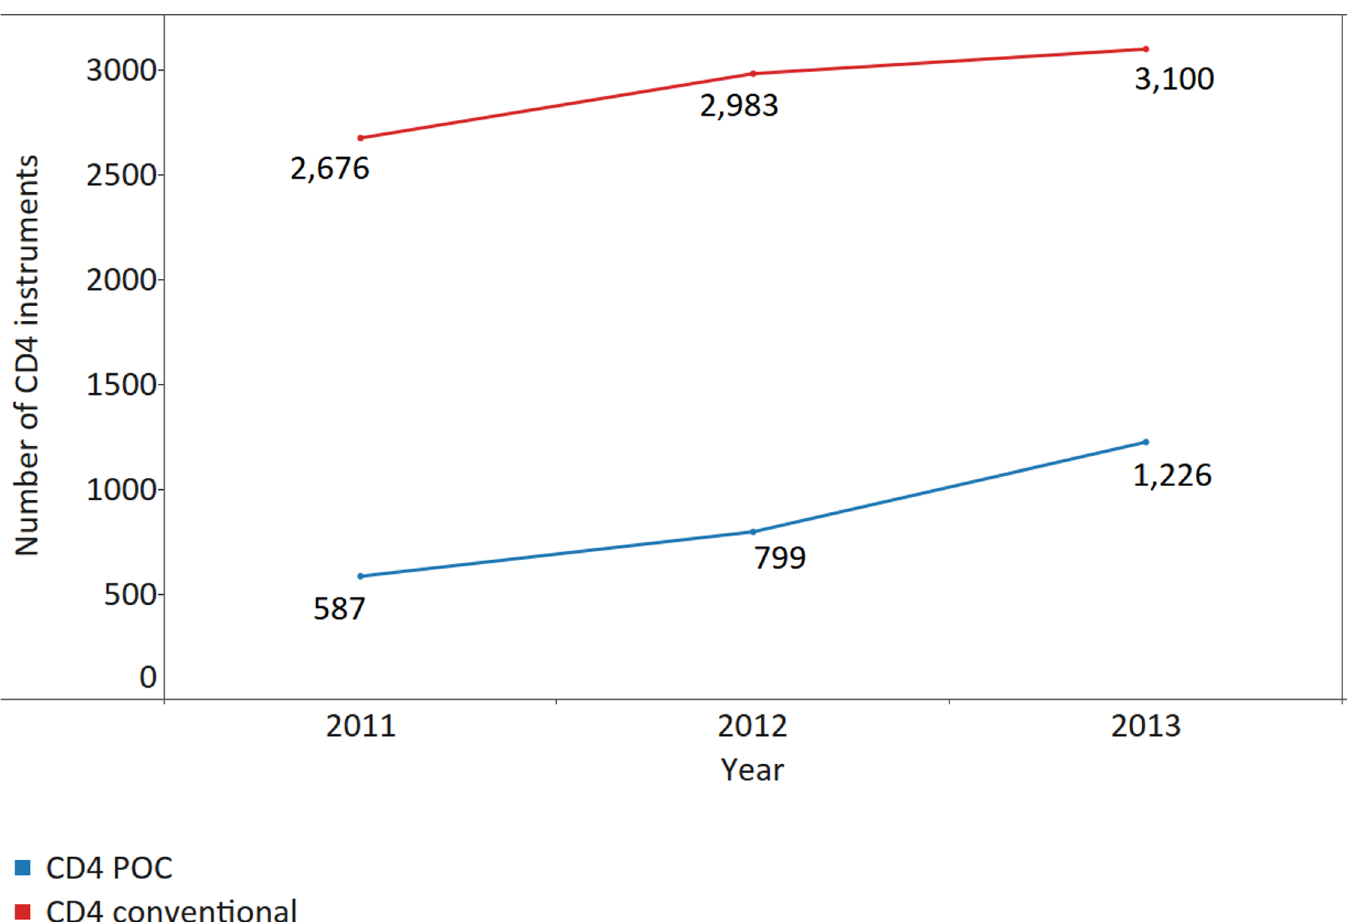
Fig 1. Increase in the number of CD4 instruments reported by 40 countries providing data for 3 consecutive y. Data labels indicate the number of reported instruments. POC, point of